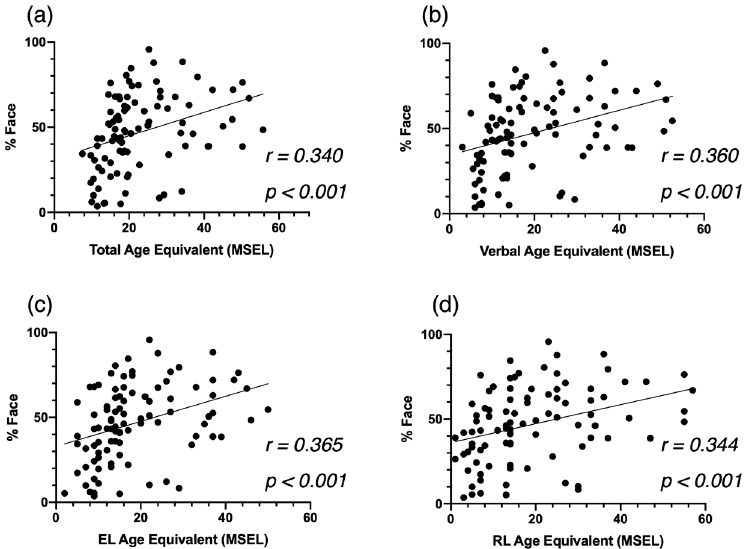
Figure 3. Correlation between %Face and the Mullen Scales of Eearly Learning (MSEL) Total AE ( a ), Verbal AE ( b ), Expressive Language AE ( c ), and Receptive Language AE ( d ), at baseline for the cross-sectional ASD group.